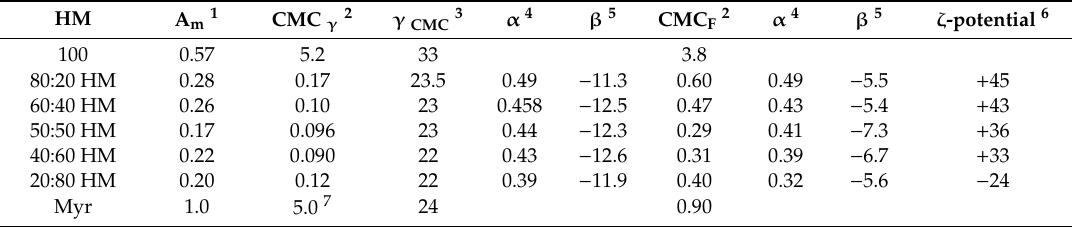
Figure 3. Surface tension as a function of total surfactant concentration for the different catanionic mixtures of DMHNHC 14 and sodium myristate and the pure components measured at 25 °C. Table 2. Surface tension and fluorescence aggregation parameters of the pure surfactants and the catanionic mixtures and ζ -potential of the